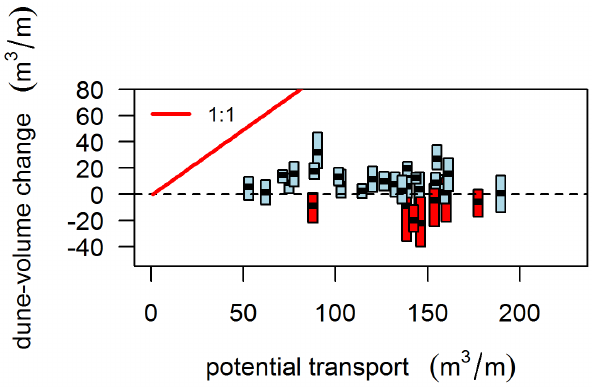
Figure 8. Dune-volume changes ( D V) as function of transport potential for Noord-Holland. Each boxplot represents the along- shore variation of a single year. Boxplots with a positive median in blue, boxplots with a negative median in red. The red line indicates the 1:1 line, where potential transport equals D V.